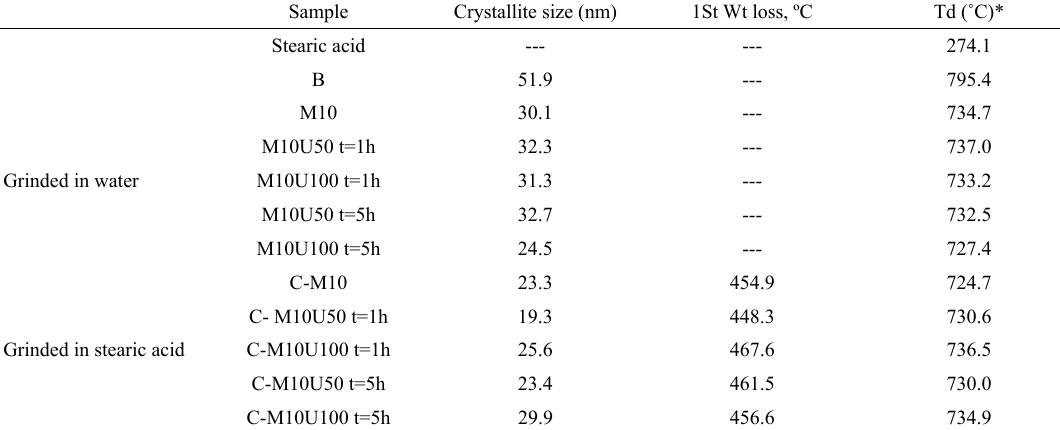
Table 1. Summary of results of X-ray diffraction and TGA analysis.